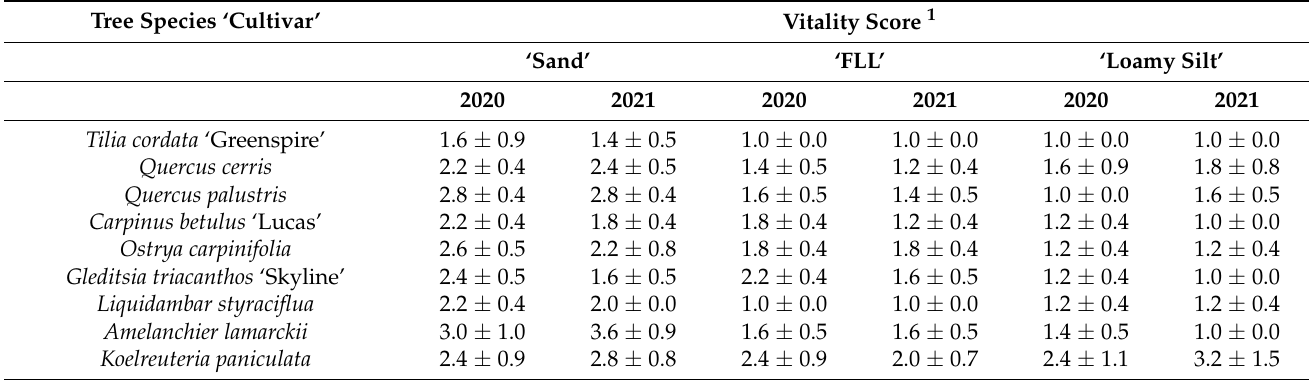
Table 3. Tree vitality score assessed by visual inspections of the tree crowns in September 2020 and 2021. Values, ranked from 1 (vital) to 5 (strongly impaired), are presented as the means ± SD for each species x planting soil combination ( n = 5).